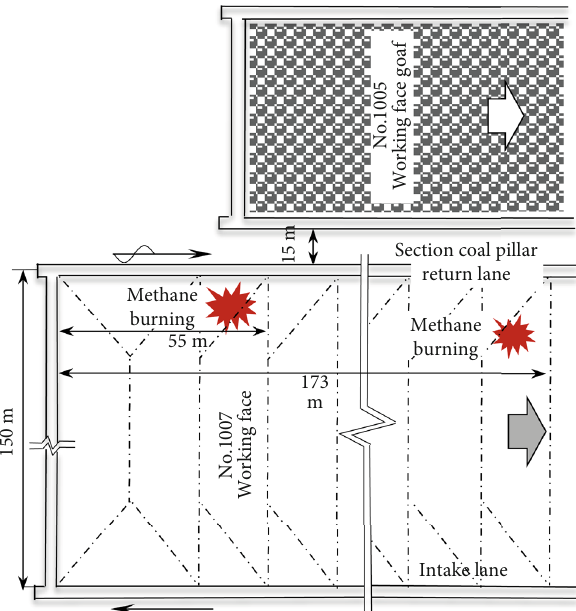
Figure 2: Layout of the working face and incident